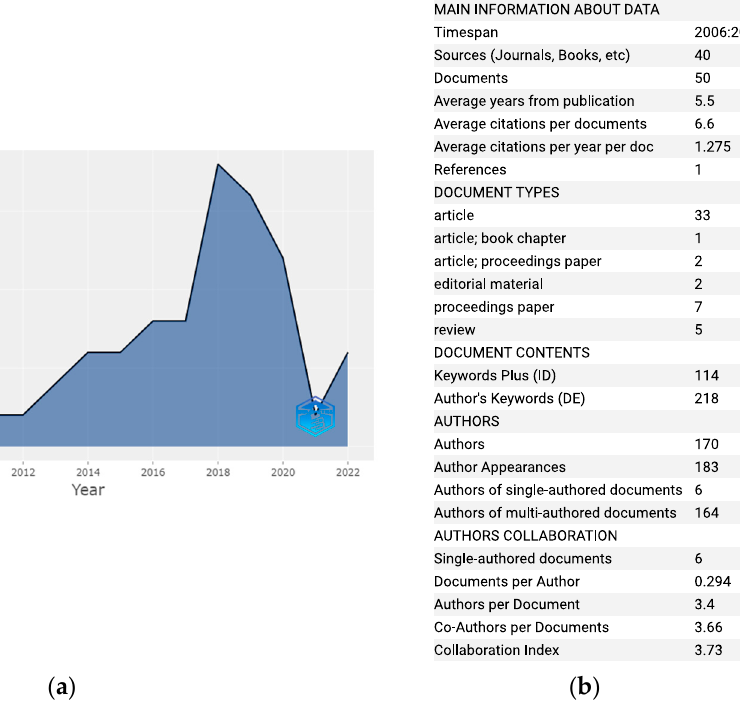
Figure 2. Bibliometric statistics of the publications on term “marine spatial data infrastructure”: ( a ) annual scientific production; ( b ) article statistics.